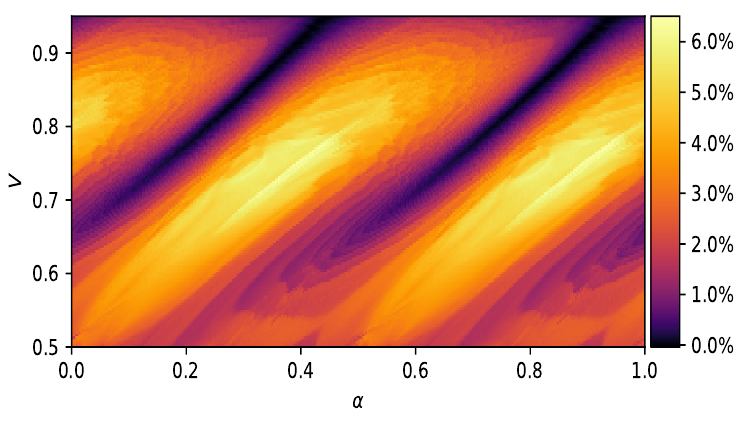
Figure 24 . Fraction of the total energy of initial con(cid:12)guration carried out by radiation for v = 0. oscillon travel with the same speed equal to 1 =V . Moreover, this expression also shows that two consecutive zeros numbered by n and n +1 lie on the same straight line if the phases of these oscillons di(cid:11)er by a certain value (cid:1) (cid:11) determined from the equation B ( n +1) ( (cid:11) +(cid:1) (cid:11) )